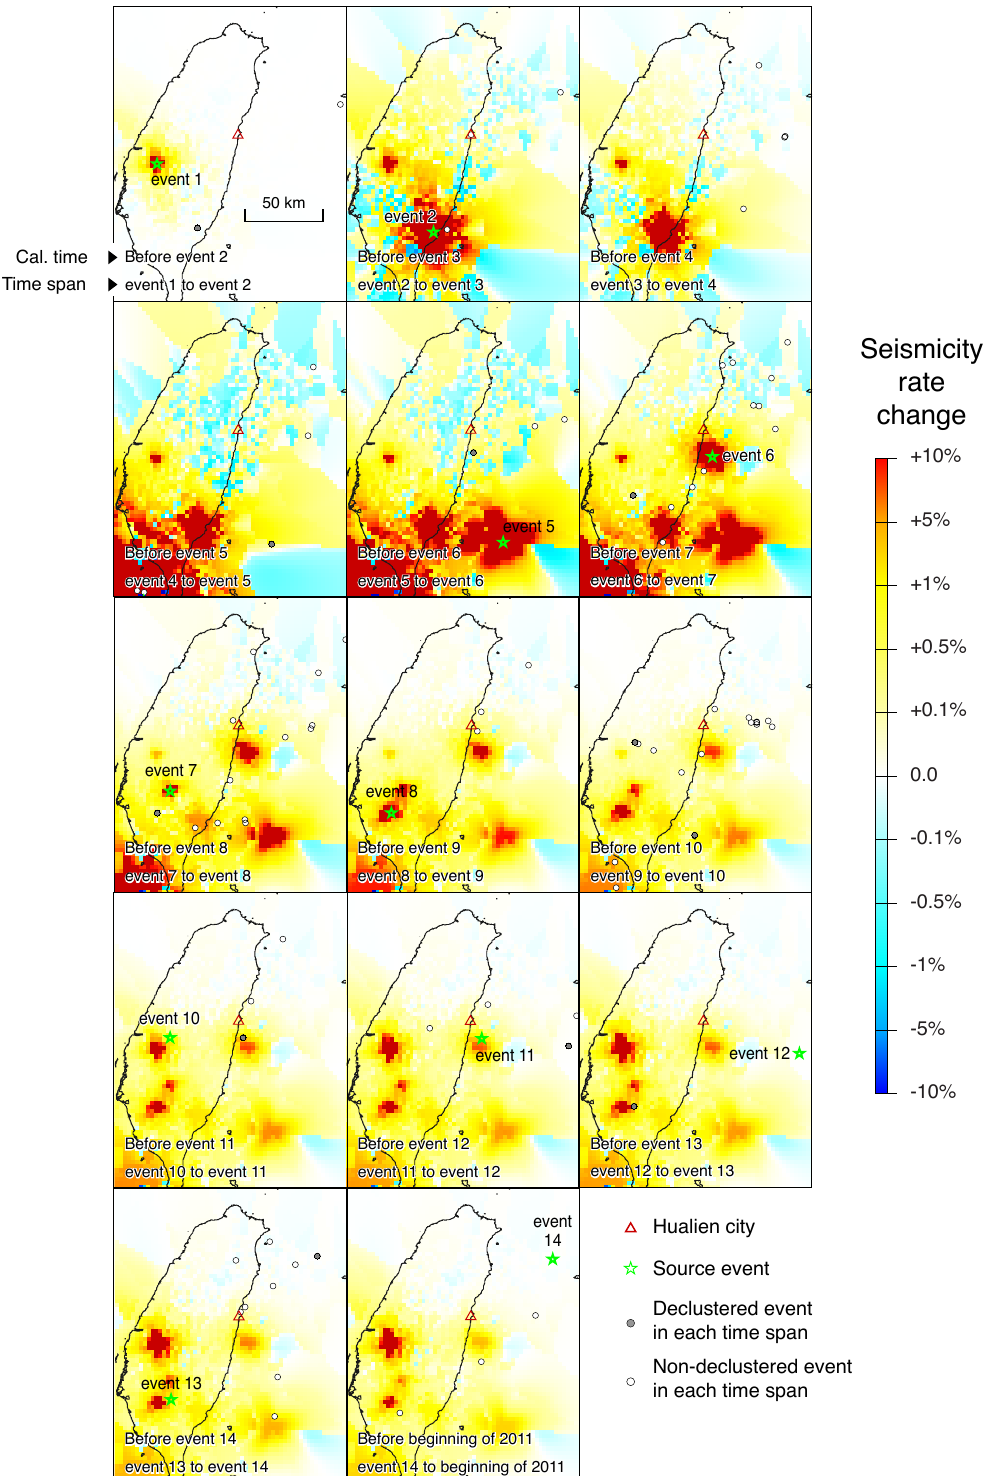
Fig. 5. The short-term seismicity rate change determined using the rate-and-state friction model from different periods. Source events during 2006–2010 are shown as open green stars. Declustering (gray dots) and non-declustering (white dots) earthquakes during each time sequence are shown. The source parameters of the source events used for calculating the seismicity rate change are shown in Table 1. Note that events 3, 4, and 9 are out of the region of the